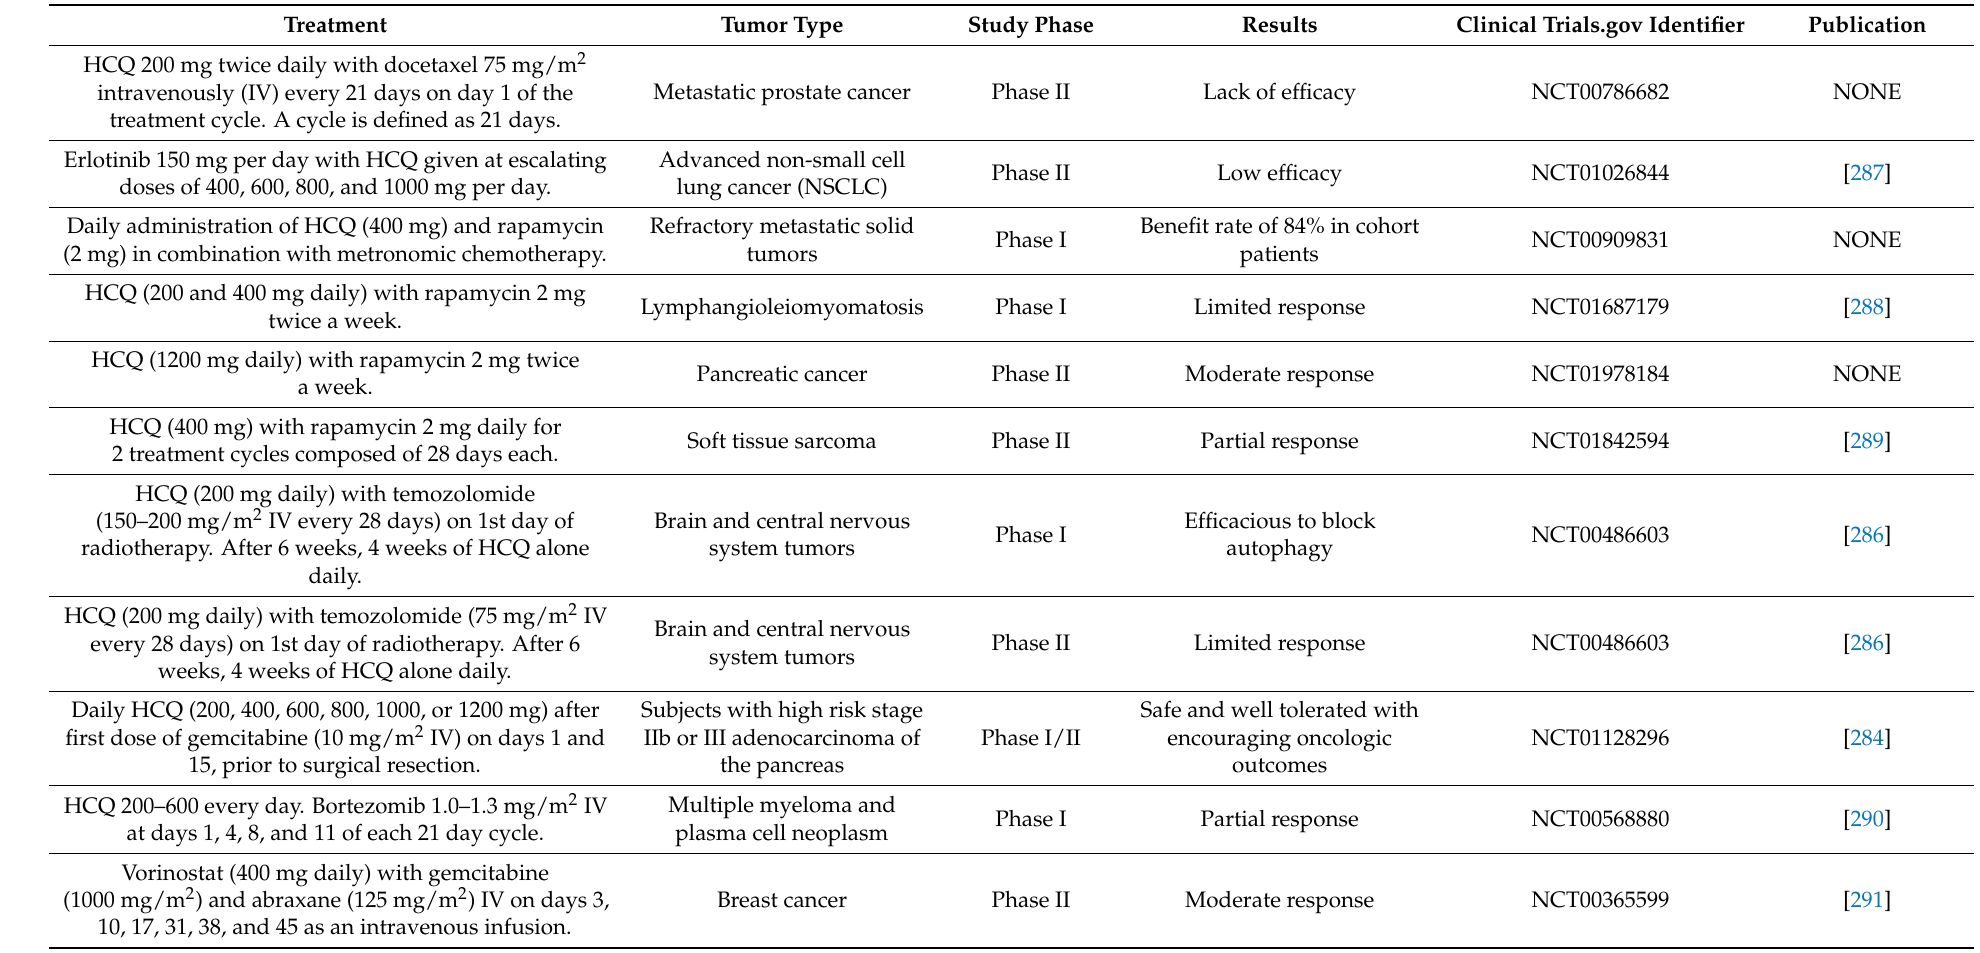
Table 2. Clinical trials reporting results on CQ and HCQ use in cancer. The entire list and full information for clinical trials investigating CQ and HCQ use in cancer are reported at: https://clinicaltrials.gov/ct2/results?cond=cancer&term=chloroquine+&cntry=&state=&city=&dist=, accessed on 30 October 2021 and